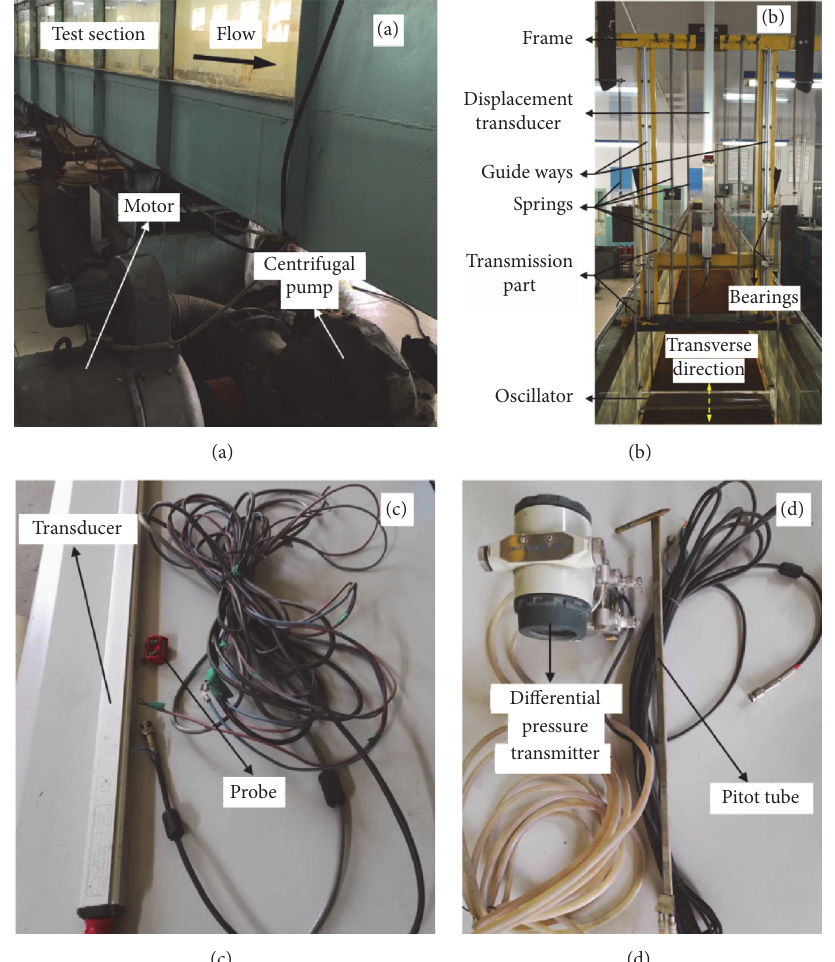
Figure 3: The experimental setup and the physical model. (a) Circular water channel; (b) experimental setup; (c) displacement transducer; (d) Pitot tube and differential pressure transmitter.